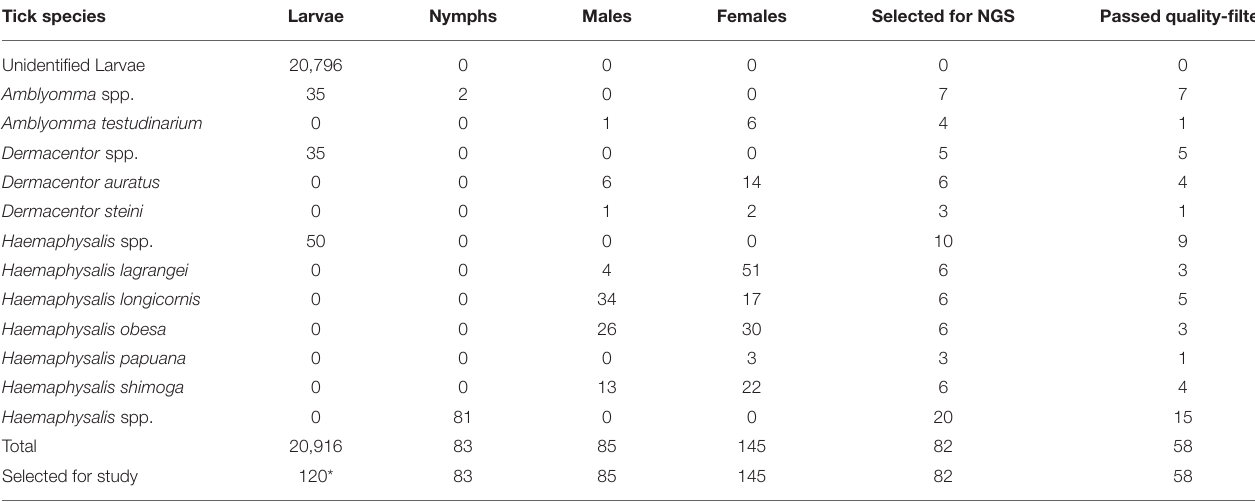
TABLE 1 | Tick species collected in Khao Yai National Park, Thailand (2020). Tick species Larvae Nymphs Males Females Selected for NGS Passed quality-filter Unidentified Larvae